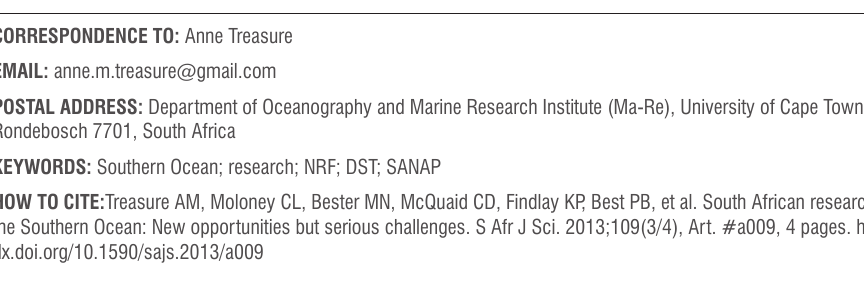
Figure 1: The SA Agulhas II moored in Cape Town harbour (photo: Anne